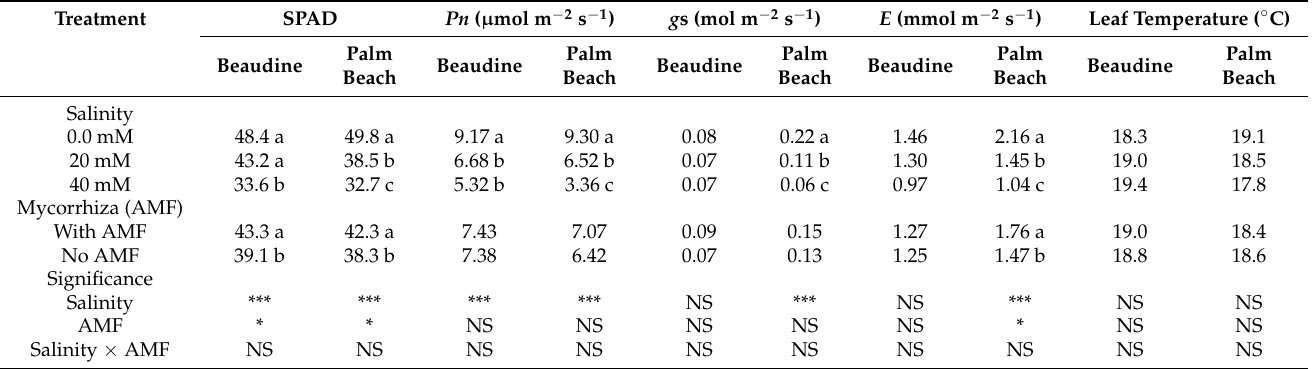
Table 2. Chlorophyll content index (SPAD), gas exchange (photosynthesis ( Pn ), stomatal conductance ( g s), and transpiration ( E )) and leaf temperature of gerbera cultivars (‘Beaudine’ red; ‘Palm Beach’ yellow) inoculated (AMF) or uninoculated (No AMF), grown under different salt stress levels in